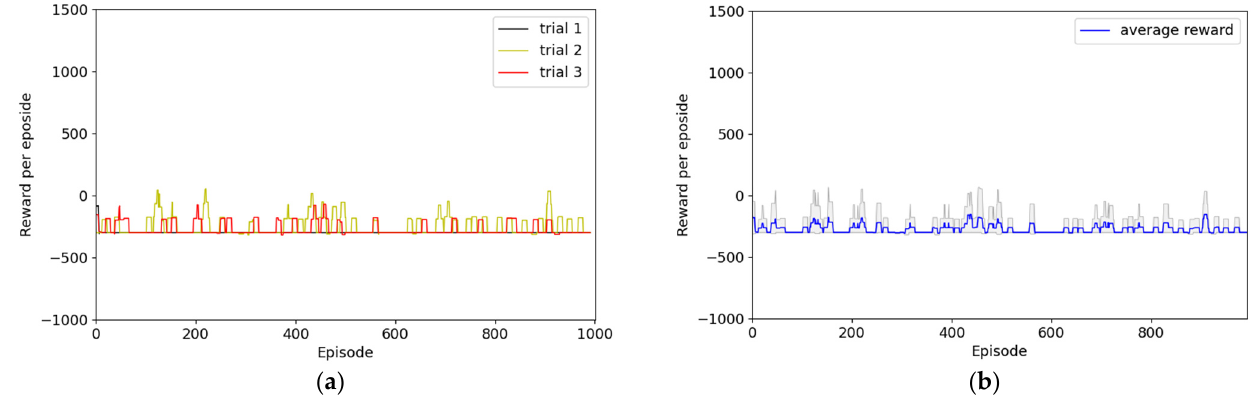
Figure 8. Results of Experiment 1: simplest reward system without HER. ( a ) Episode rewards for each of the three trials; ( b ) maximum, minimum, and average values of episode rewards considering all three episodes.